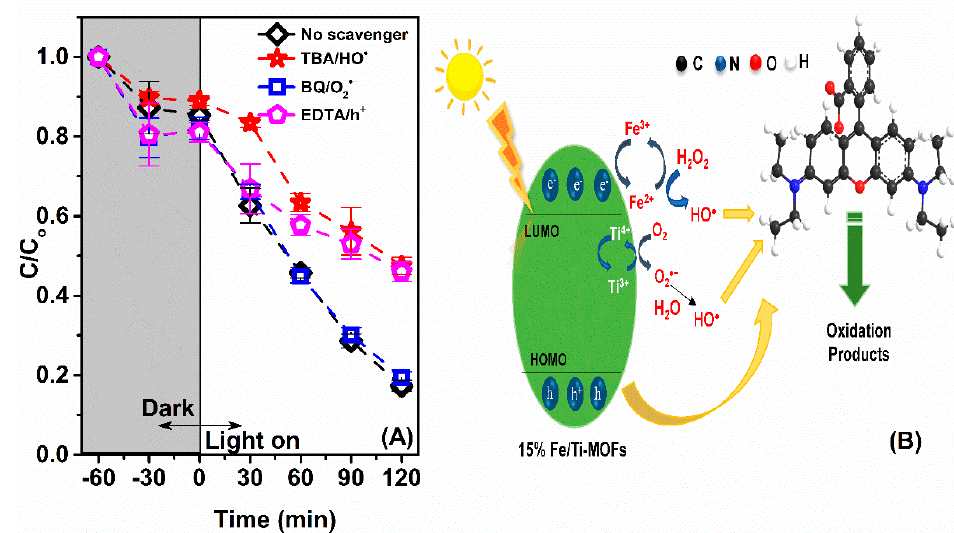
Figure 9. ( A ) Effect of radical scavengers; ( B ) Illustration of the proposed reaction mechanism on Rhodamine degradation over 15% Fe/Ti-MOFs. Reaction conditions: Rhodamine B 3.10 − 5 M, H 2 O 2 2 mM, 5 mg 15% Fe/Ti-MOFs catalyst.